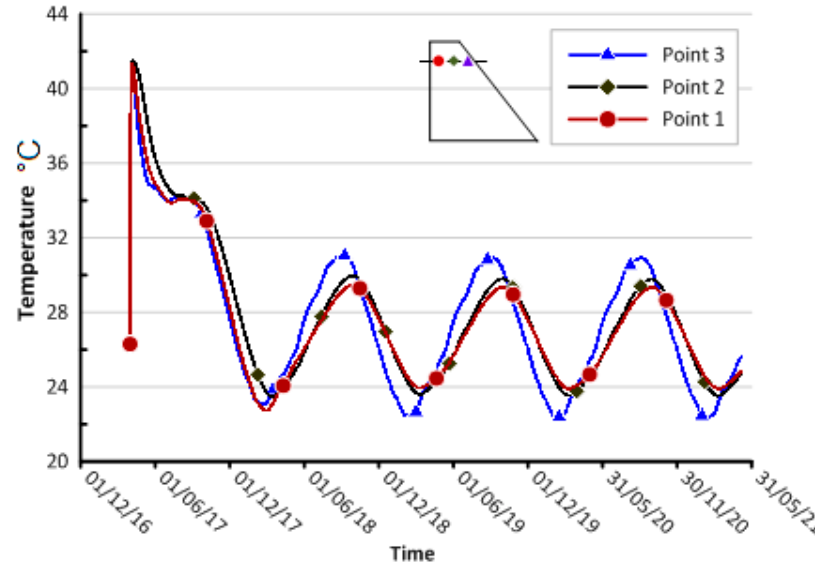
Figure 6. Temperature variation at three middle points at 63 m